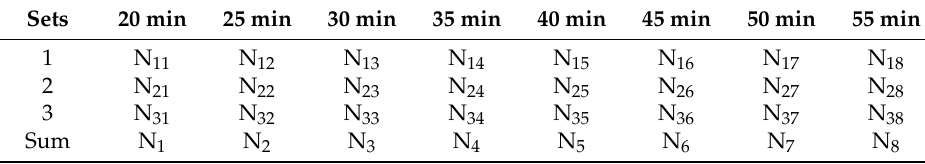
Table 1. The number of tracks at different time for three tests.